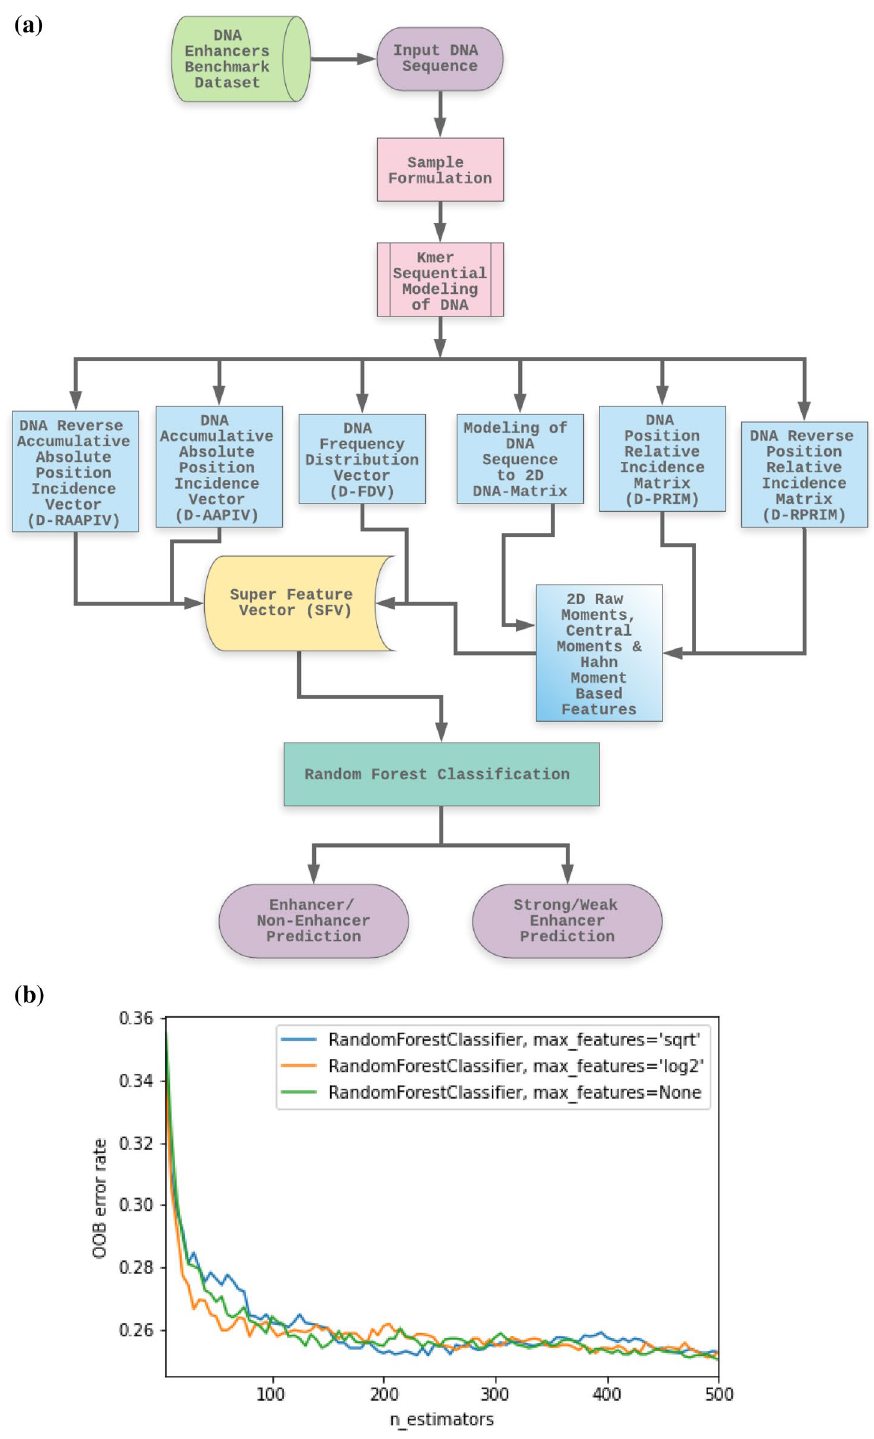
Figure 8. ( a ) The Flowchart of the overall proposed method. ( b ) The OOB error rate stabilization during training estimator